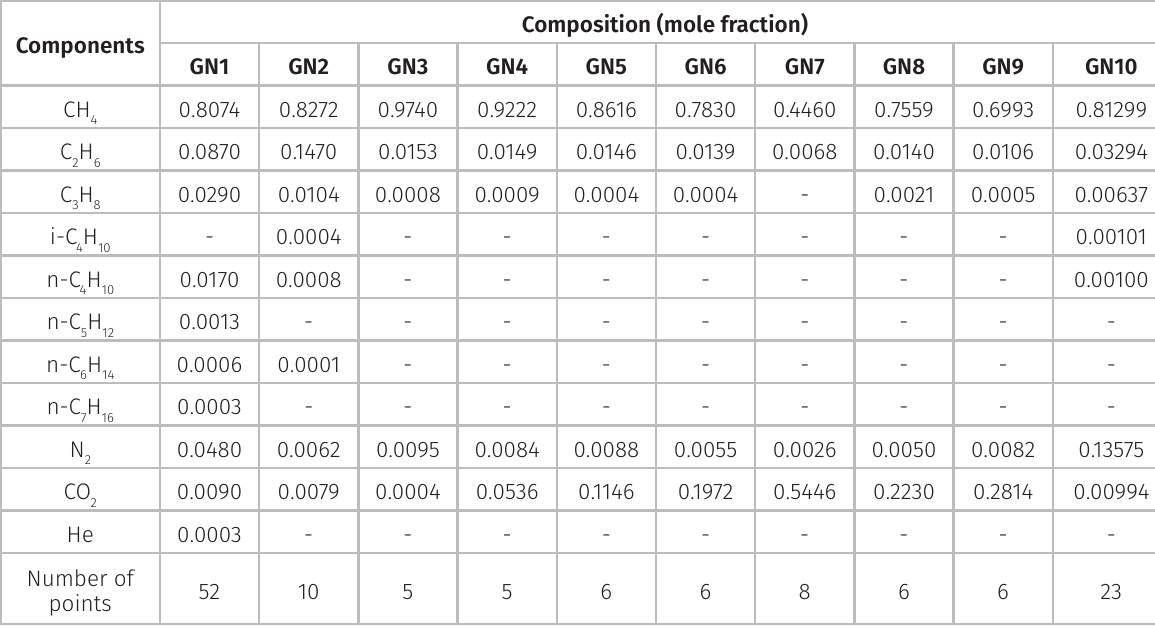
Table III. Compositions of the mixtures used for molar volume prediction. Components